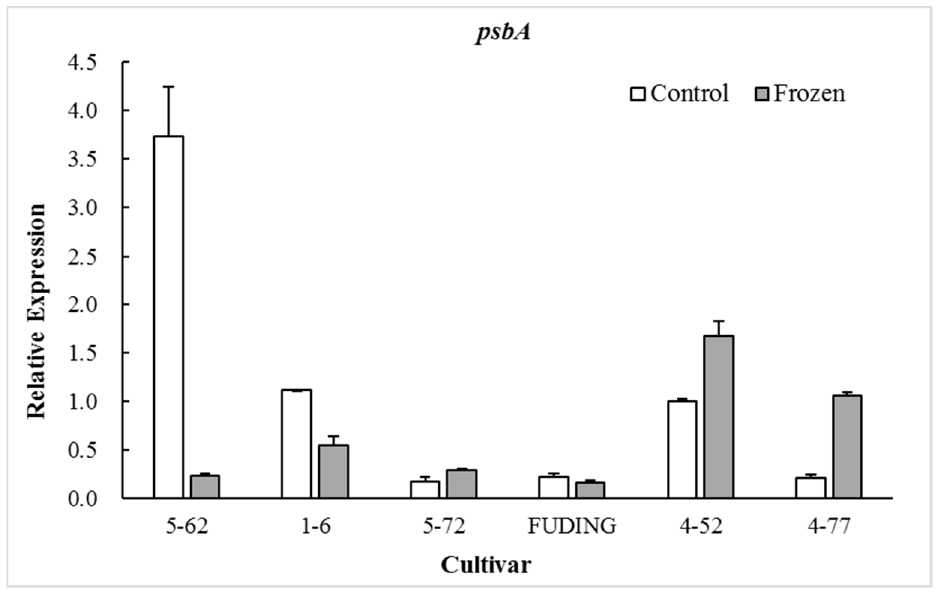
Figure 1. Effect of freezing on the expression of gene psbA . Figure 1. E ff ect of freezing on the expression of gene psbA